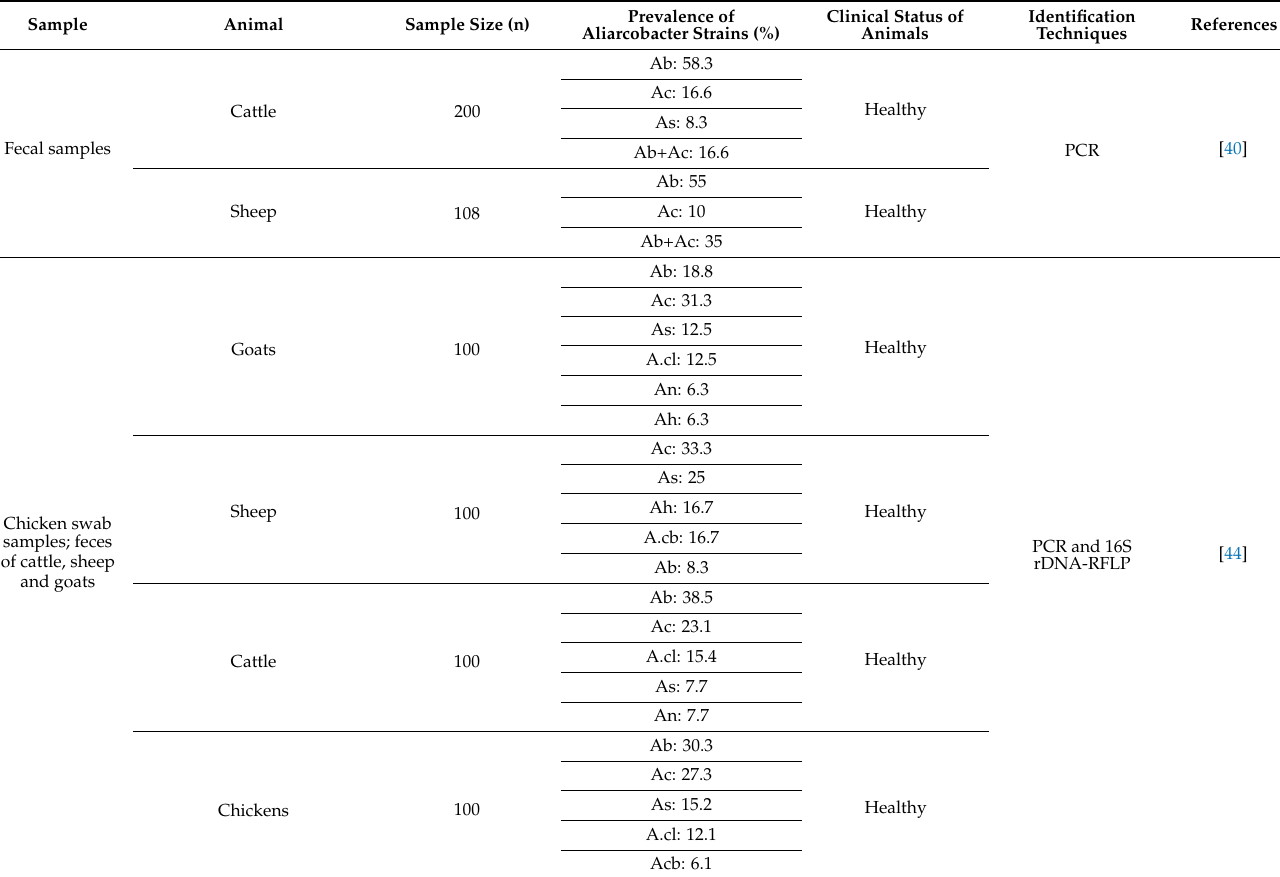
Table 1. Relative (%) prevalence rates of Aliarcobacter in intestinal samples of farm animals over the past